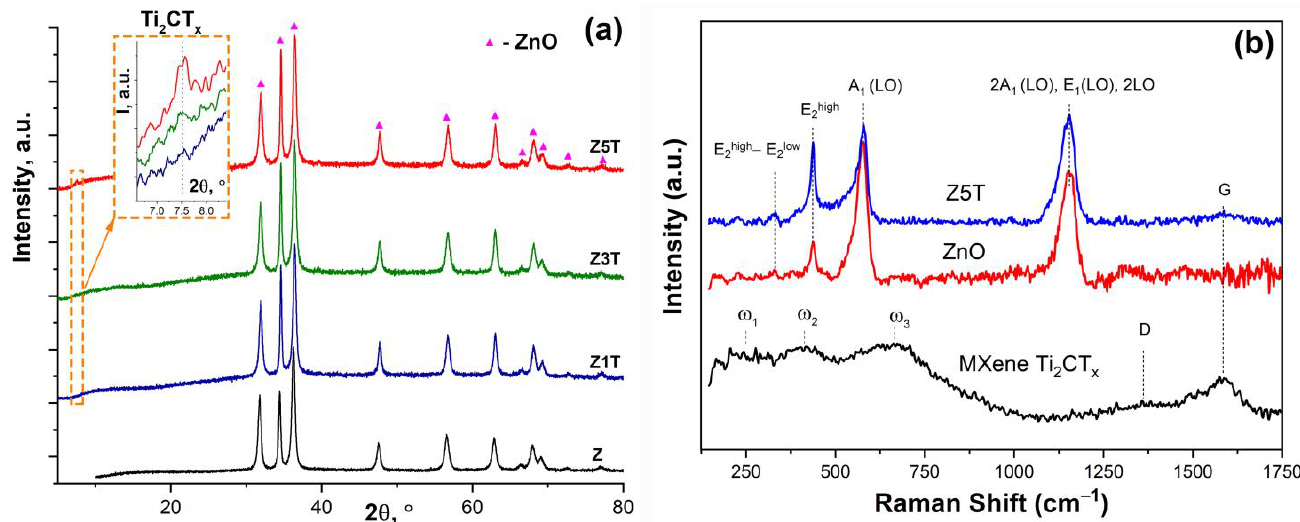
Figure 4. X-ray diffraction patterns of the obtained powders Z, Z1T, Z3T and Z5T ( a ) and Raman spectra of Ti 2 CT x MXene powders and Z and Z5T samples (b) .